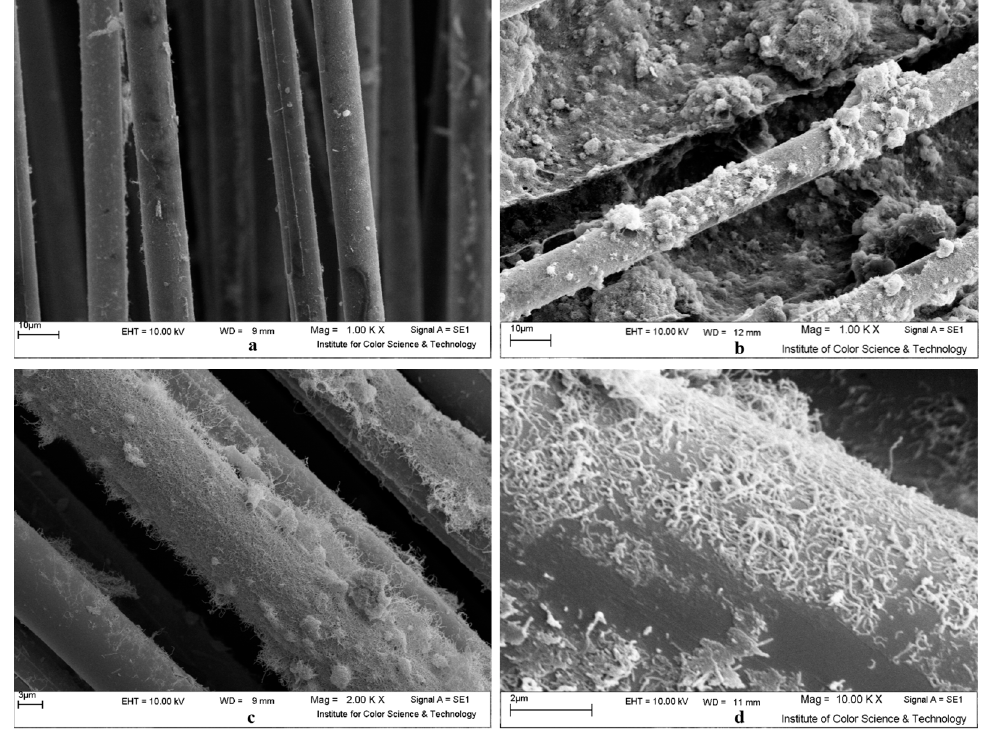
Figure 2. Scanning electron microscopy (SEM) images of CNT deposited glass fibers for ( a ) poor, ( b ) strong, and ( c , d ) optimum EPD parameters setting.